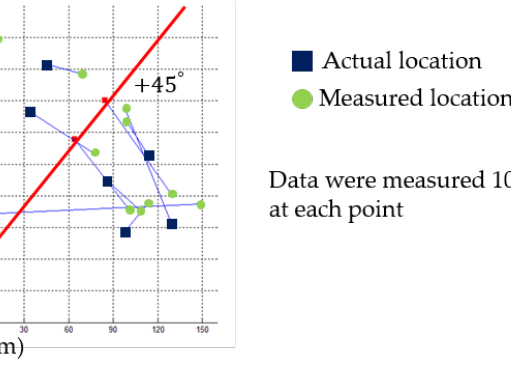
Figure 12. Control factors of the mobile robot.